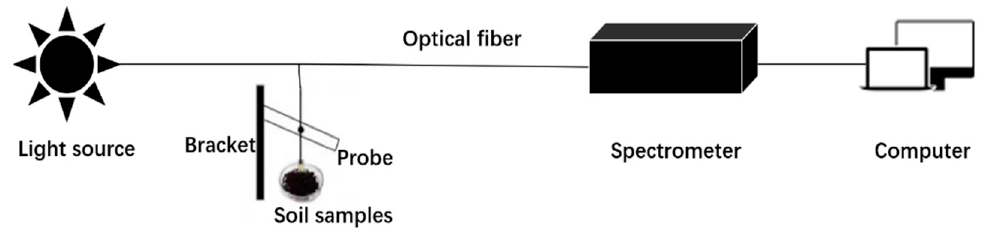
Figure 1. Schematic diagram of the experimental system.